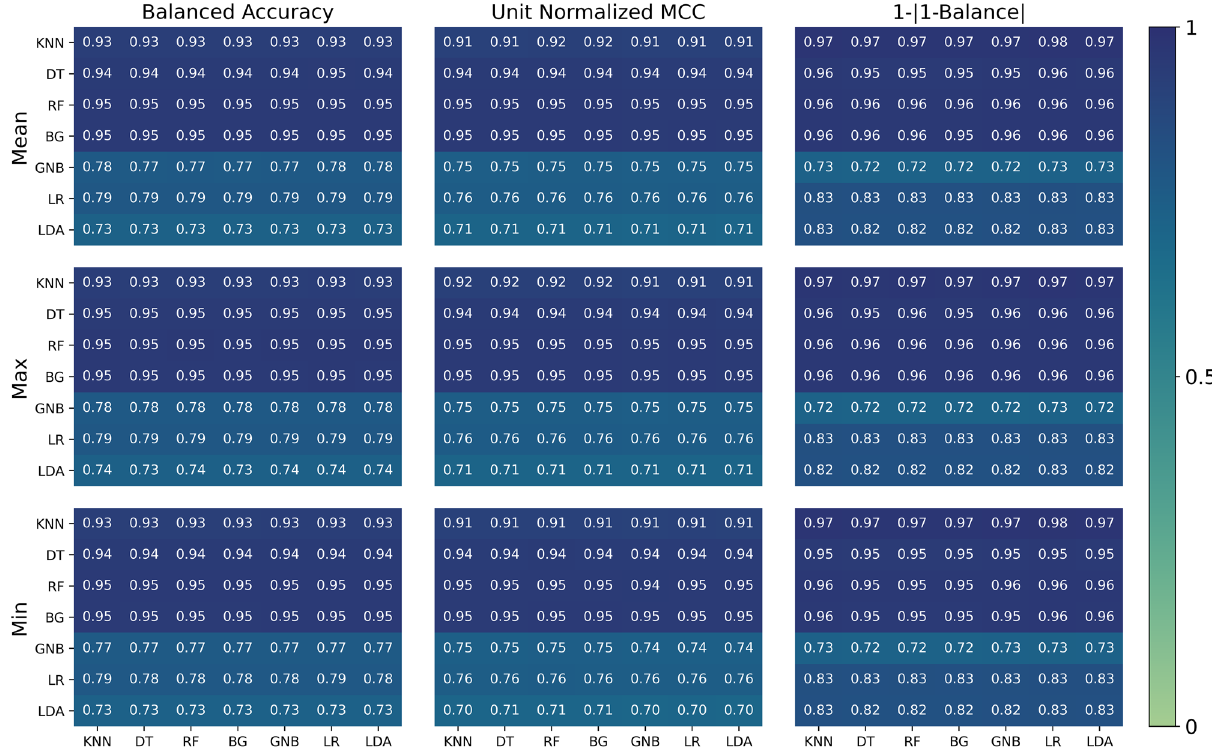
Figure 4. The obtained classification measures for the considered 49 sole and hybrid classification schemes. The main columns from left to right correspond to BA, UM, and 1 correspond to the weighted cross-validated mean, best, and worst models. The point groups are divided into two sets depending on whether they have a high positive count or low positive count. The threshold is 19K positive counts, which represents 1% of the total number data. The vertical (horizontal) axis refers to the classifier applied on the high (low) positive count set. For each panel, the diagonal cells illustrate the scores using a single type of classifier for both sets while the off-diagonal cells consist of the scores from a distinct pair of classifiers.